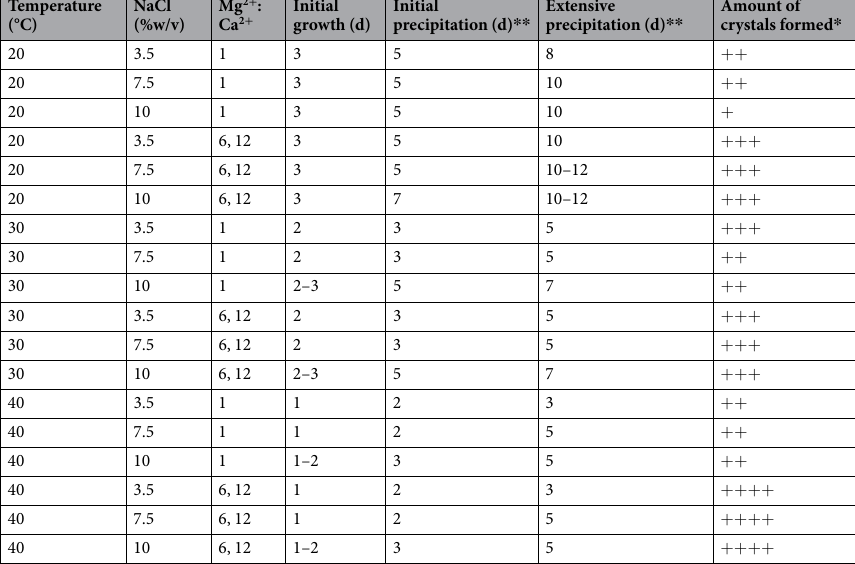
Table 1. Results of culture experiments for mineral forming strains at different temperatures and NaCl (%w/v) observed by optical microscope (40 × ). Adapted from corresponding PhD Dissertation 71 . * Qualitative estimation, average number of crystals/mm 2 , + : 1–14, ++ : 15–49, +++ : 50–99, ++++ : > 100. ** Only for